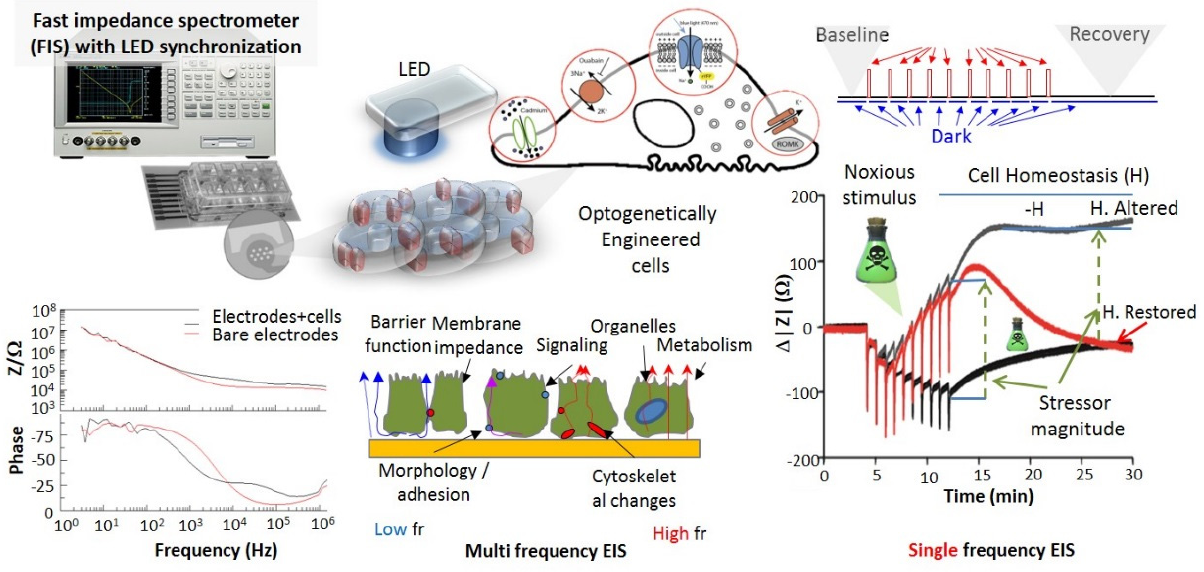
Figure 3. Schematic representation of a cell-based impedance sensing system with optogenetic control. The cells grown on the electrode act as insulators, impeding the flow of current, perturbing the impedance of the system as revealed by multi frequency Electrical Impedance Spectroscopy (EIS). Upon light control of optogenetic actuators, the characteristic impedance response (black) is rapidly and specifically modified upon addition of compounds able to alter individual cell characteristics (cell morphology, cytoskeleton, metabolism, cell signaling) or to disrupt the cell monolayer (affecting cell–cell communication or cell-surface attachment). Access to the whole dynamics, including the recovery phase, has predictive potential concerning the persistence of the compound-specific bio-effect (i.e., altered homeostasis/homeostasis restora- tion).